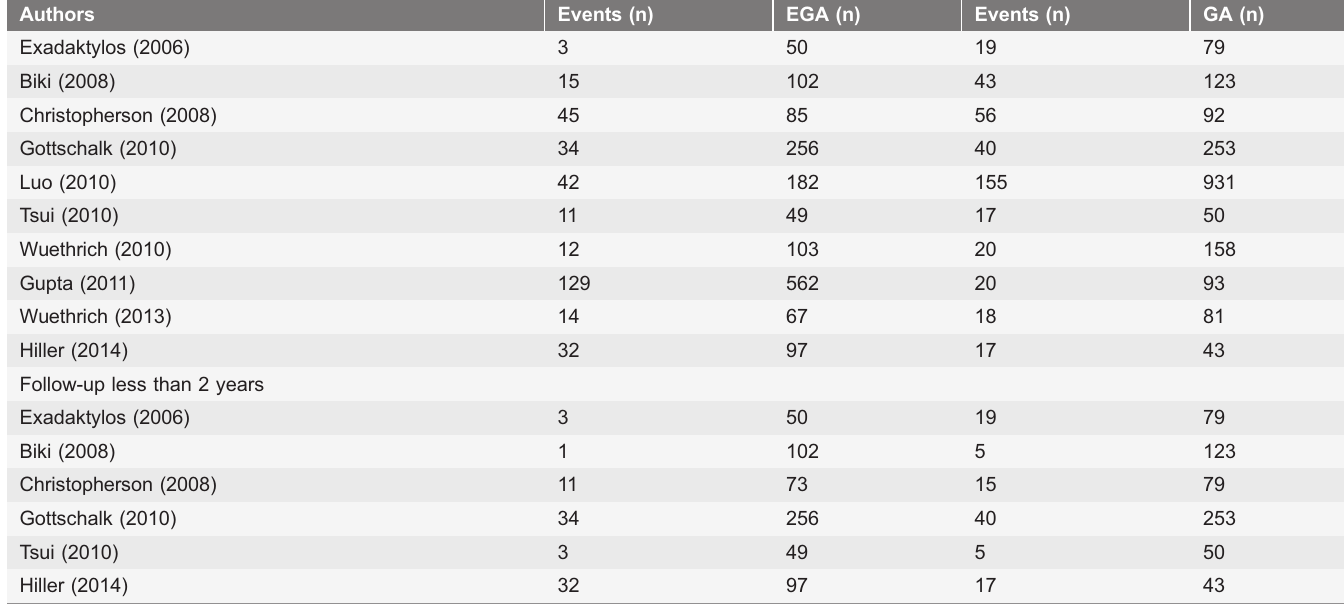
Table 2. Basic characteristics of included studies (Number of